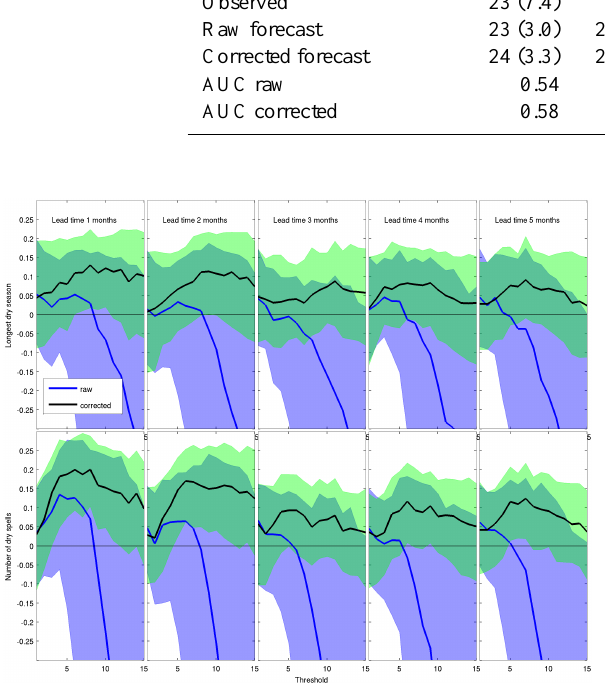
Figure 7. CRPSS as a function of precipitation thresholds for dif- ferent lead times over the Limpopo catchment. Top panel shows the results for the longest dry spell over the rainy season, and the bottom panel the frequency of dry spells over the rainy season. The blue line denotes the raw forecast, and the black line the bias-corrected. The blue (green) areas denote the 5 to 95 spread of the raw (corrected) forecasts respectively.